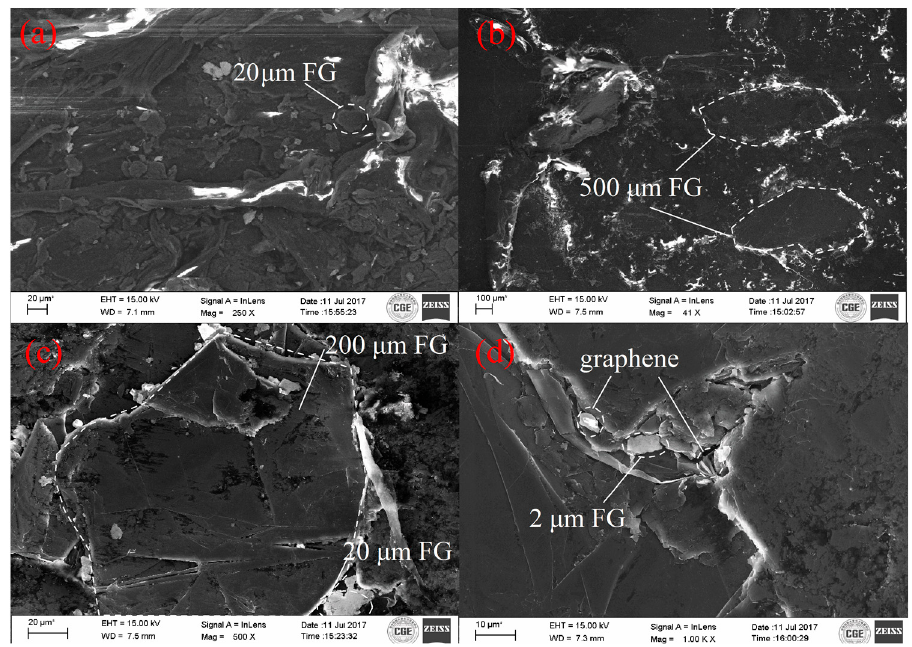
Figure 6. The scanning electron microscope (SEM) micrographs of HDPE/FG composites; ( a ) 40 wt % 20 μ m FG and 60 wt % HDPE; ( b ) 40 wt % 500 μ m FG and 60 wt % HDPE; ( c ) 15 wt %, 500 μ m/10 wt % 200 μ m/10 wt % 20 μ m/5 wt % 2 μ m FG and 60 wt % HDPE; ( d ) 15 wt % 500 μ m/10 wt % 200 μ m/10 wt % 20 μ m/4 wt % 2 μ m FG/1 wt % graphene and 60 wt % HDPE.